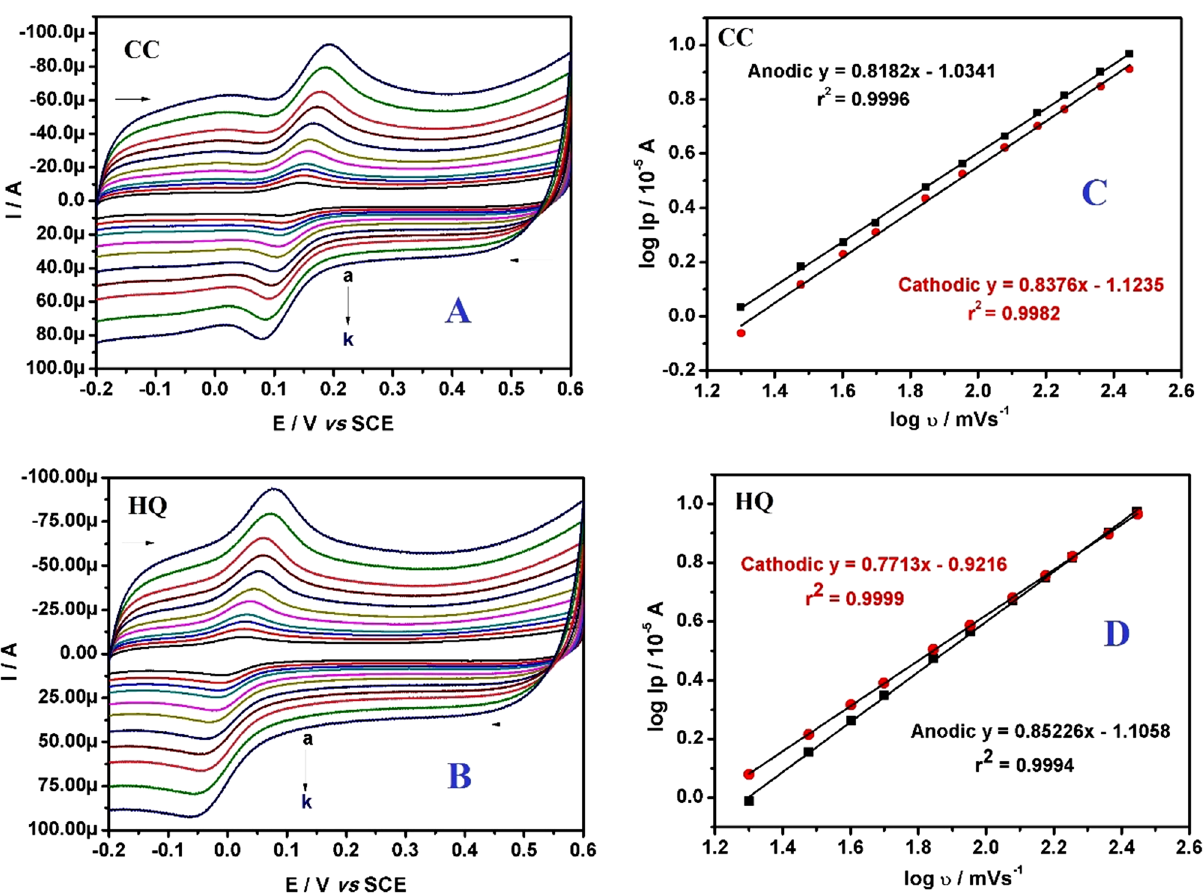
Figure 6. ( A ) CVs on impact of scan rates (a–k: 20, 30, 40, 50, 70, 90, 120, 150, 180, 230, 280 mVs −1 ) on electrooxidation of 20.0 μM CC at polysorbate/CPE in buffer (0.2 M PBS; pH 7.4). ( B ) CVs on impact of scan rates (a–k: 20, 30, 40, 50, 70, 90, 120, 150, 180, 230, 280 mVs −1 ) on electrooxidation of 20.0 μM HQ at polysorbate/CPE in buffer (0.2 M PBS; pH 7.4). ( C ) Graph of log Ip versus log υ of CC. ( D ) Graph of log Ip versus log υ of